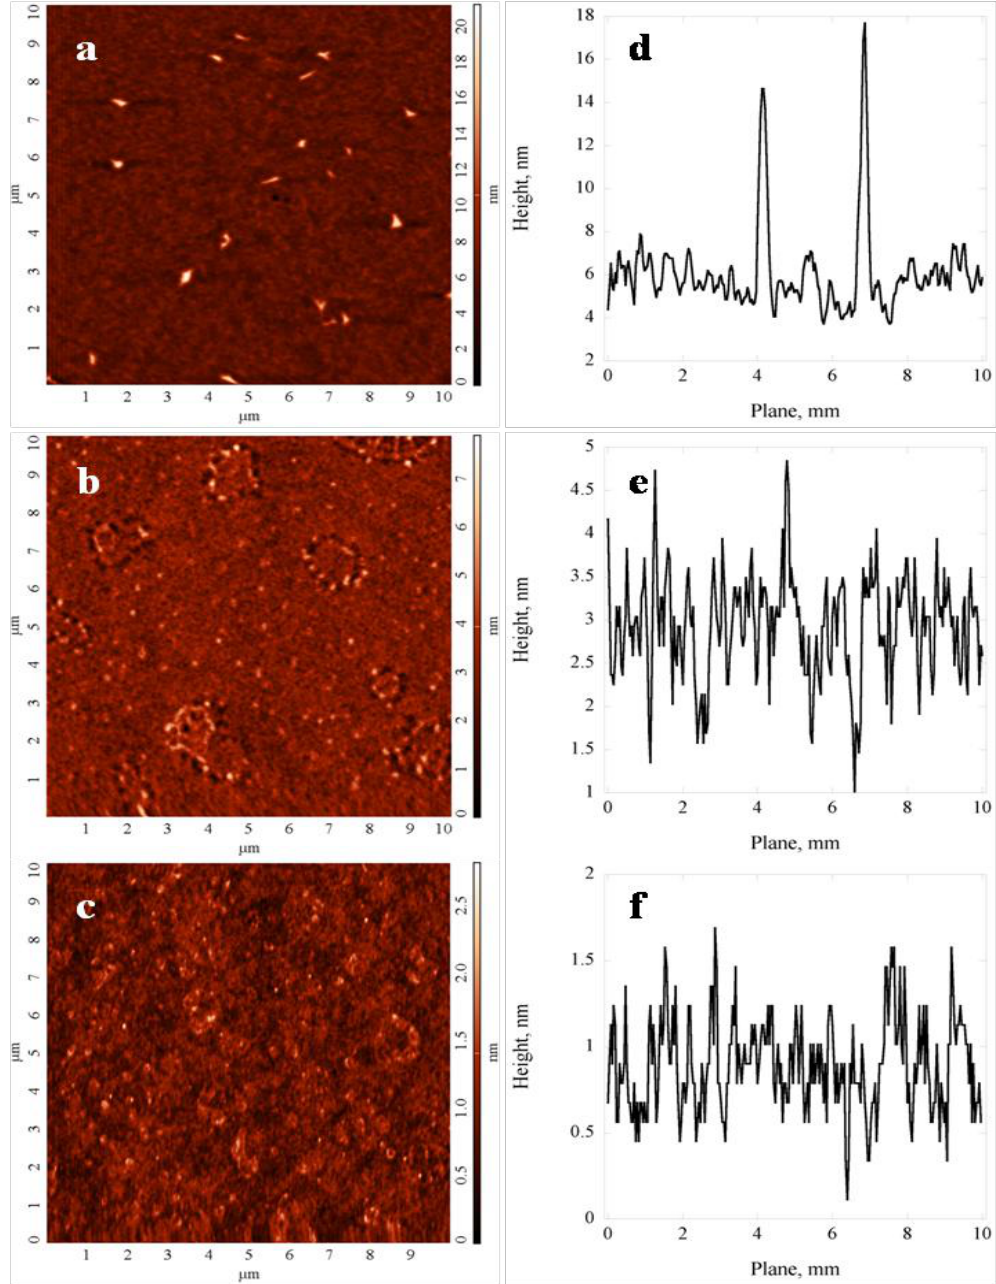
Figure 1. Typical two-dimensional (2D) atomic force microscope (AFM) images and surface profiles of glass ( a and d , respectively) and polyterpenol thin film surfaces fabricated at 10 W ( b and e , respectively) and 25 W ( c and f , respectively) from an approximately 10 μm × 10 μm scanned